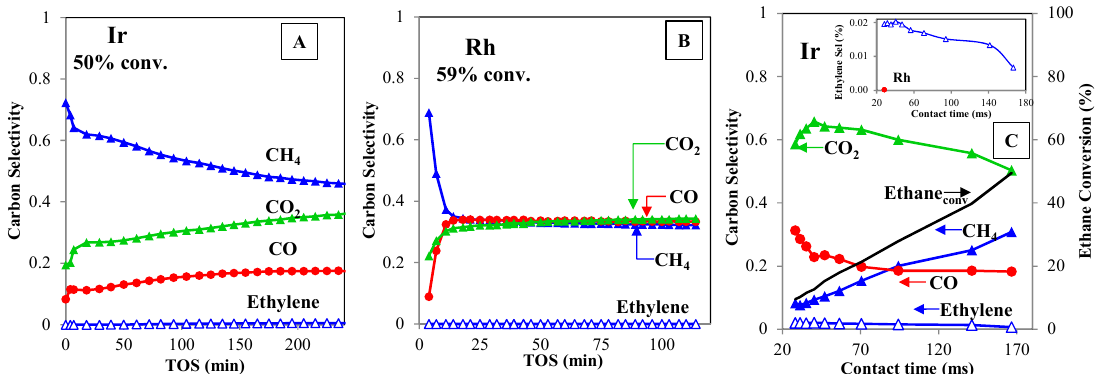
Figure 5. Product selectivity for ethane steam reforming at 600 °C (S/C = 2.75 mol, τ = 28 ms [Rh]; τ = 167 ms [Ir]; ethane feed = 16 vol %) over Ir/MgAl 2 O 4 catalyst at 50% ethane conversion ( A ), over Rh/MgAl 2 O 4 catalyst at 59% ethane conversion ( B ). Variation of carbon selectivity with ethane contact time over Ir/MgAl 2 O 4 catalyst ( C ).